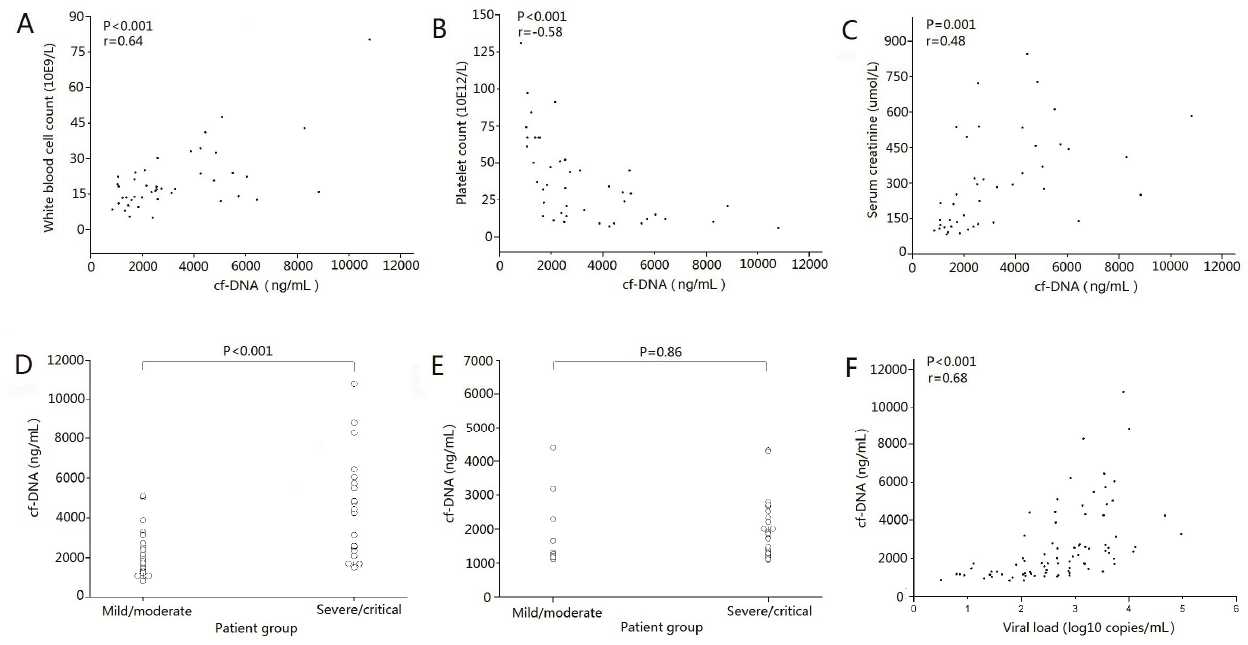
Figure 2. Relationship between plasma cf-DNA level in acute phase (febrile/hypotensive stages) from 44 samples and the peak value of white blood cell count ( A ) and the lowest value of platelet count ( B ), and the peak value of serum creatinine ( C ). Comparison of plasma cf-DNA level between the mild/moderate group and the severe/critical group in febrile/hypotensive stage ( D ) and oliguric stage ( E ). Positive correlation of plasma cf-DNA level with viral load in febrile/hypotensive stage ( F ). p values of <0.05 were considered statistically